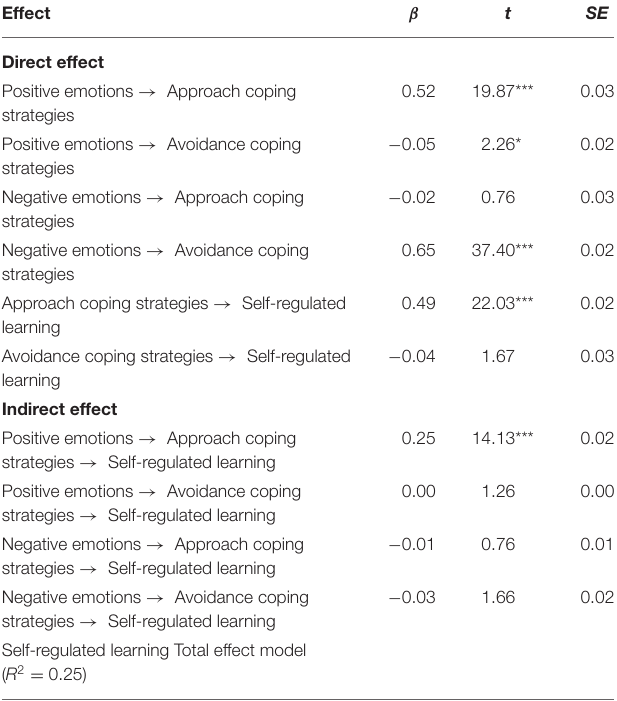
TABLE 3 | Measurement model results.